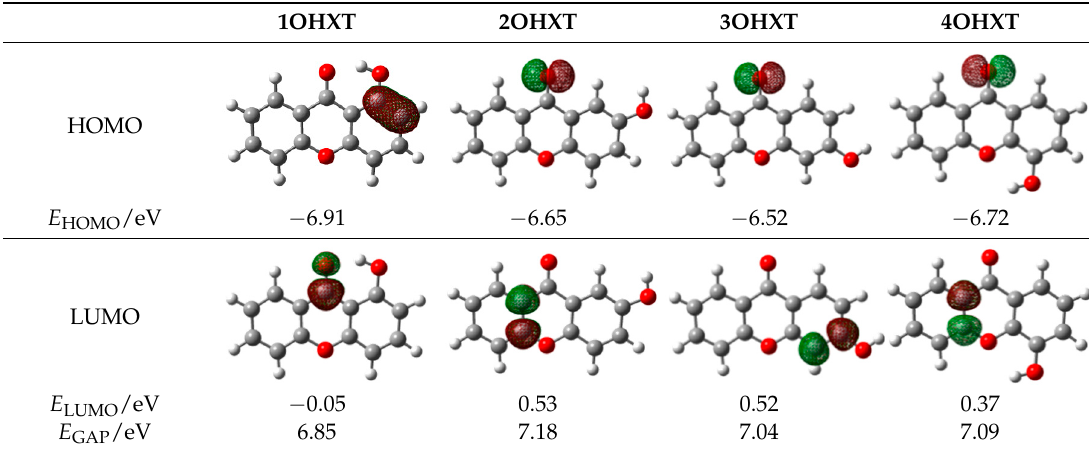
Table 2. HOMO and LUMO maps (isovalue for molecular orbitals of 0.06 e ⋅ a 0 − 3 , where a 0 is the Bohr radius) with the correspondent energies values, E HOMO and E LUMO , and the calculated energy gap, E GAP . 1 eV corresponds to 1.6021766208 × 10 − 19 J [28] a .